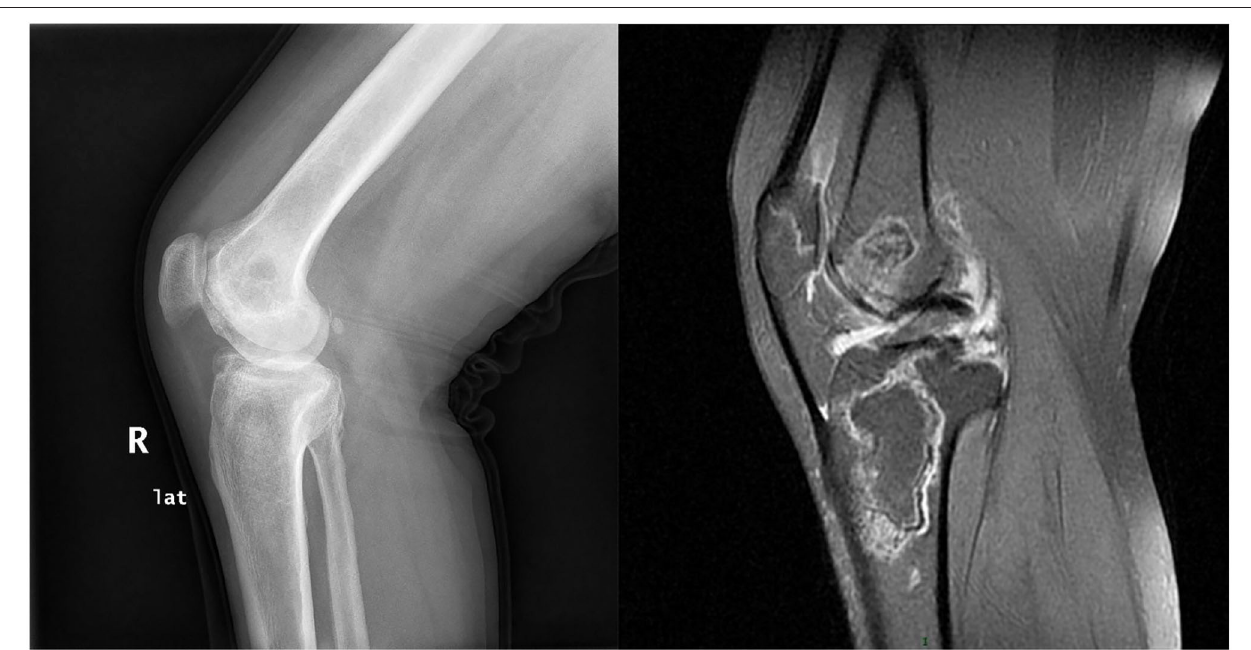
FIGURE 3 | A 48-year-old woman with a history of SLE for 7 years was diagnosed with knee